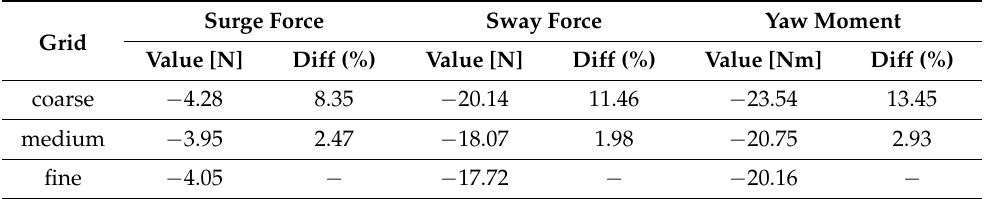
Table 3. Grid dependency analysis for oblique motion at β 0 = − 10 ◦ in calm water.